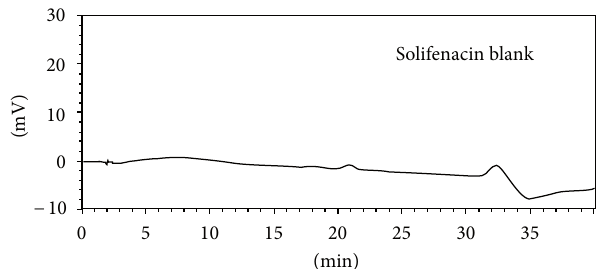
F 4: Typical HPLC chromatogram of pure solifenacin succi- nate spiked with 0.15 of impurity-A, impurity-B, and impurity-C. %